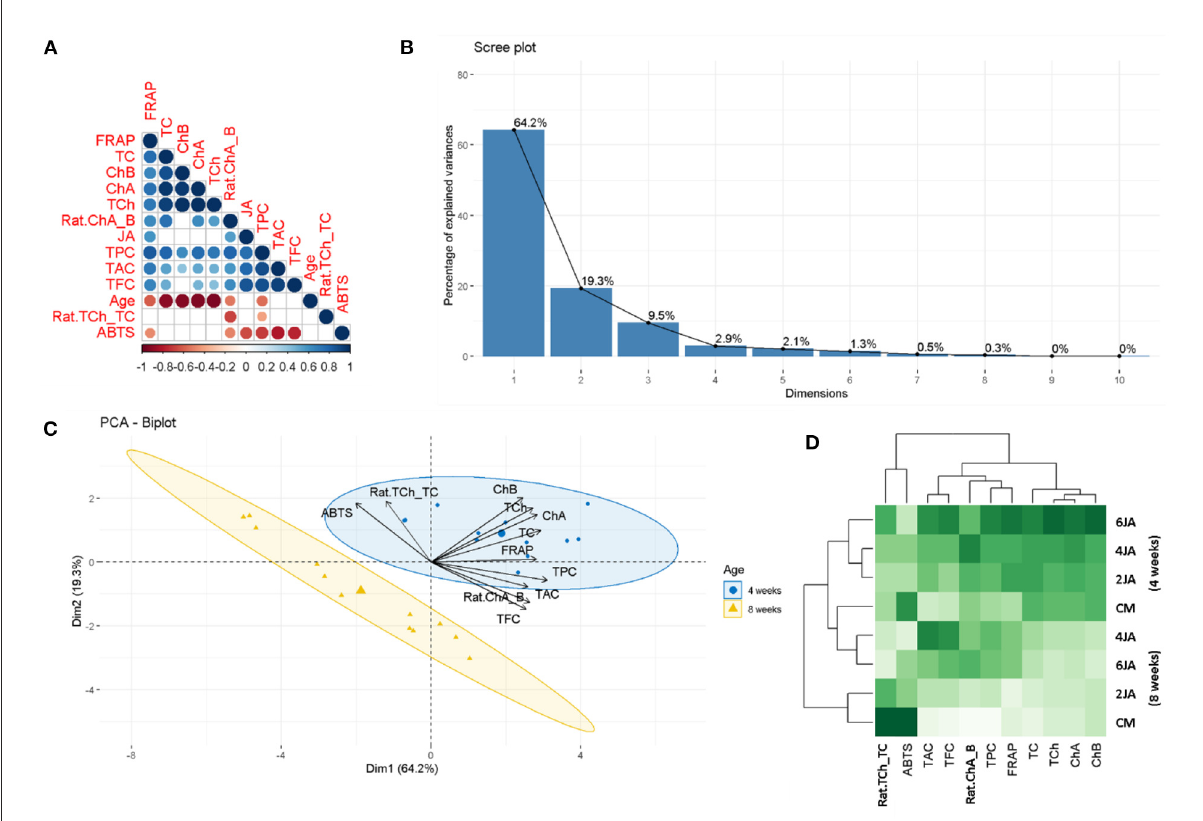
FIGURE5 Statistical evaluations between the parameters, (A) Corrplot describing the correlation coefficients between JA concentration, samples age, bioactive pigments and antioxidant properties, (B) Scree plot depicting the percentage of explained variances, (C) PCA-biplot summarizing the distribution of the tested extracts (from different storage period) on the factorial plan and representation of biological activities on the correlation circle, and (D) Heat map showing the relationship between JA concentrations with bioactive pigments and biological